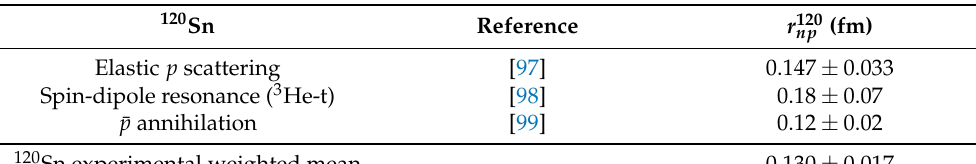
Table 7. 120 Sn neutron skin measurements with 1 σ